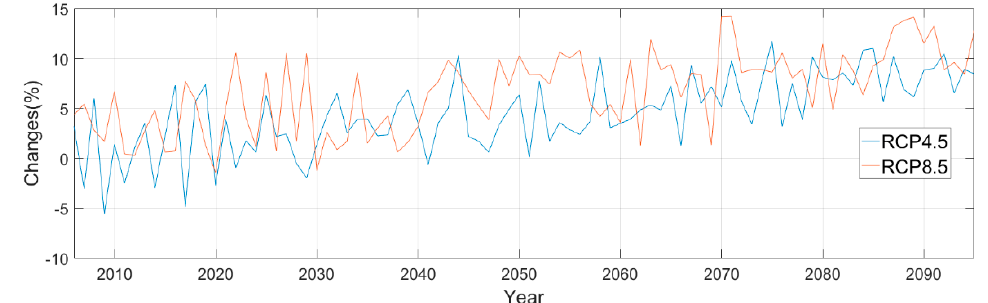
Figure 6. Yearly changes of project precipitation under RCP4.5 and RCP8.5 compared to baseline year (1981–2000).